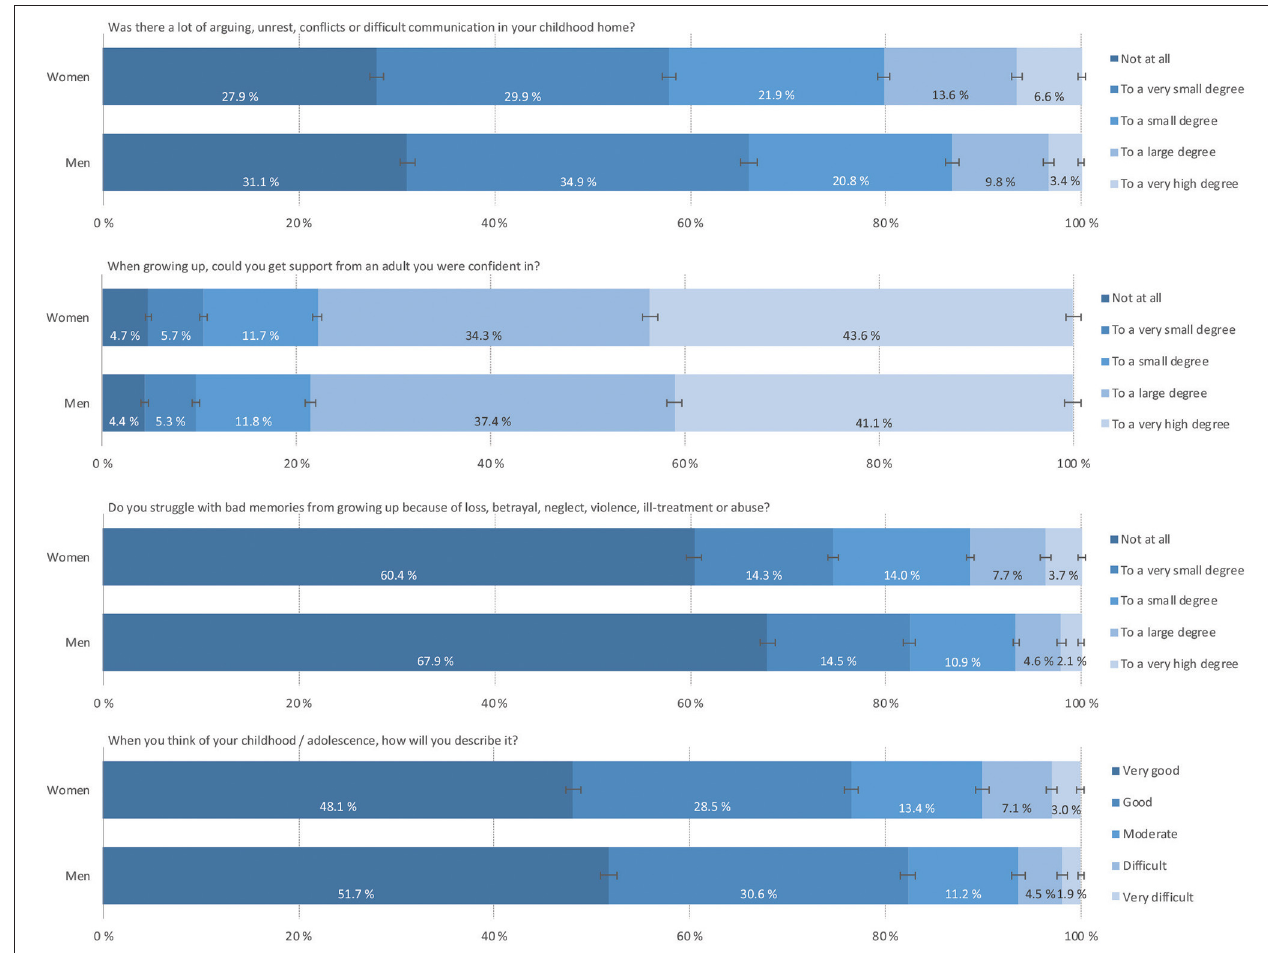
FIGURE 1 | The prevalence of ACEs among Norwegian adults from a general population, grouped by participant sex. Data retrieved from the Norwegian Counties Public Health Survey conducted in Agder, 2019.